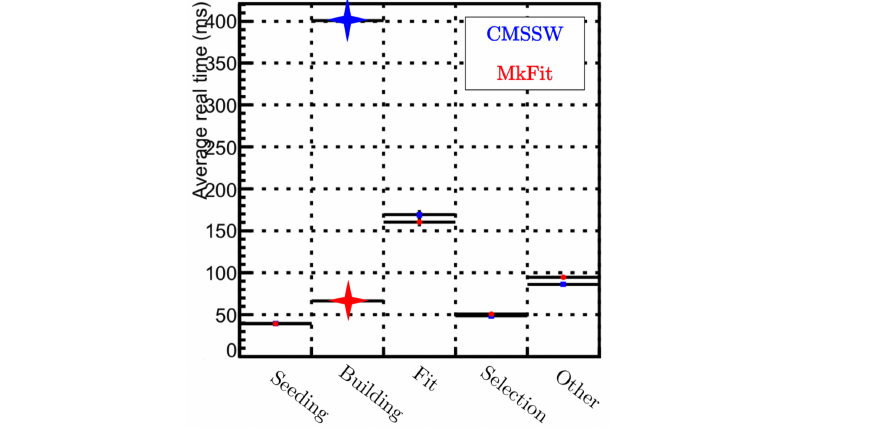
Figure 3. Time for the various steps of the initial iteration for a single-threaded execution of the CMSSW tracking on SKL. Track building with mkFit is compared to the CMSSW default. The sample used are t ¯ t events with an average PU of